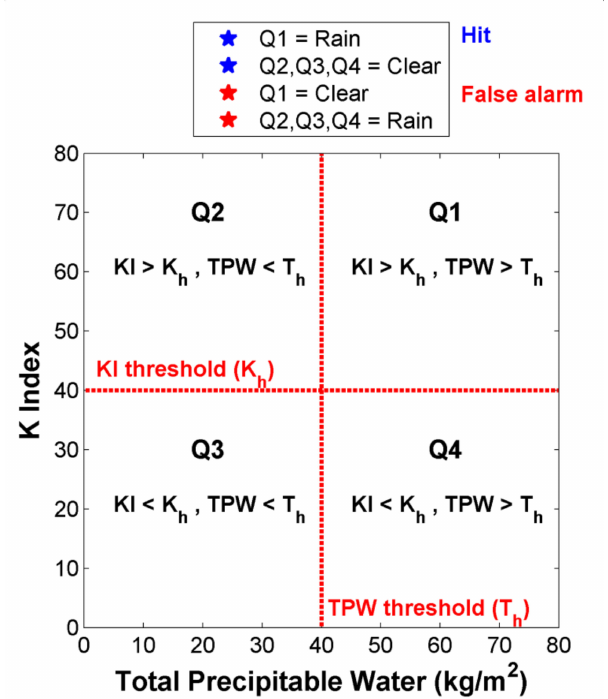
Figure 3. Evaluation of accuracy for TPW and KI of the afternoon convection of each